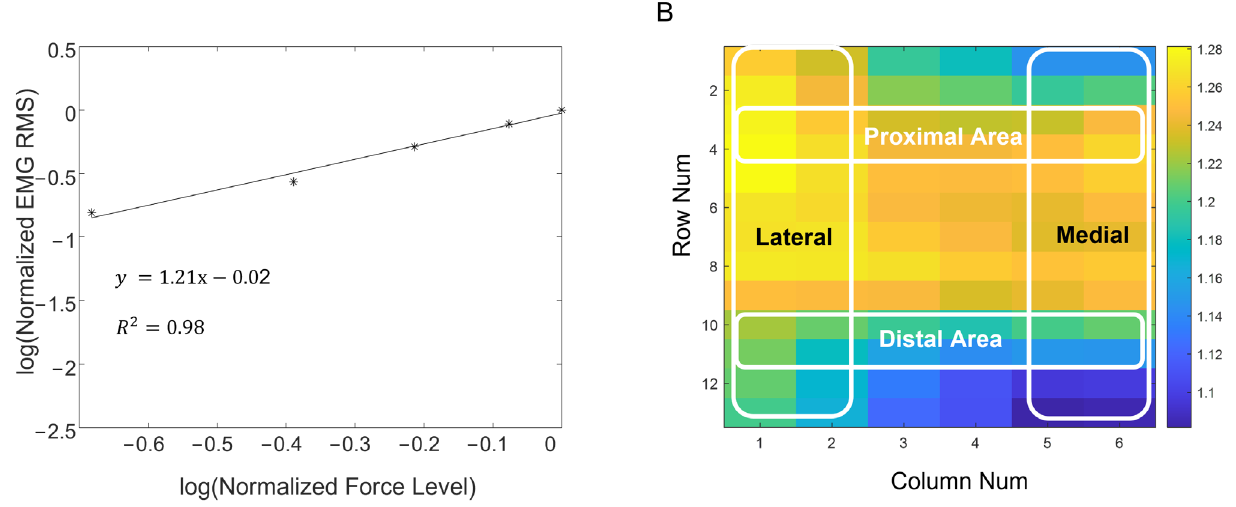
Figure 5. ( A ) The log transformed normalized EMG RMS–force relation (averaged from all electrodes) in a representative subject. ( B ) The distribution of b across all electrodes for the subject.